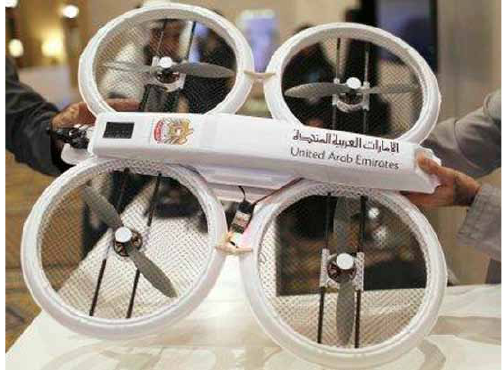
Fig. 5. The UAE drone prototype (Source: http://www. technocrazed.com/uae-government-planning-to-use-drones- for-delivering-official-documents)